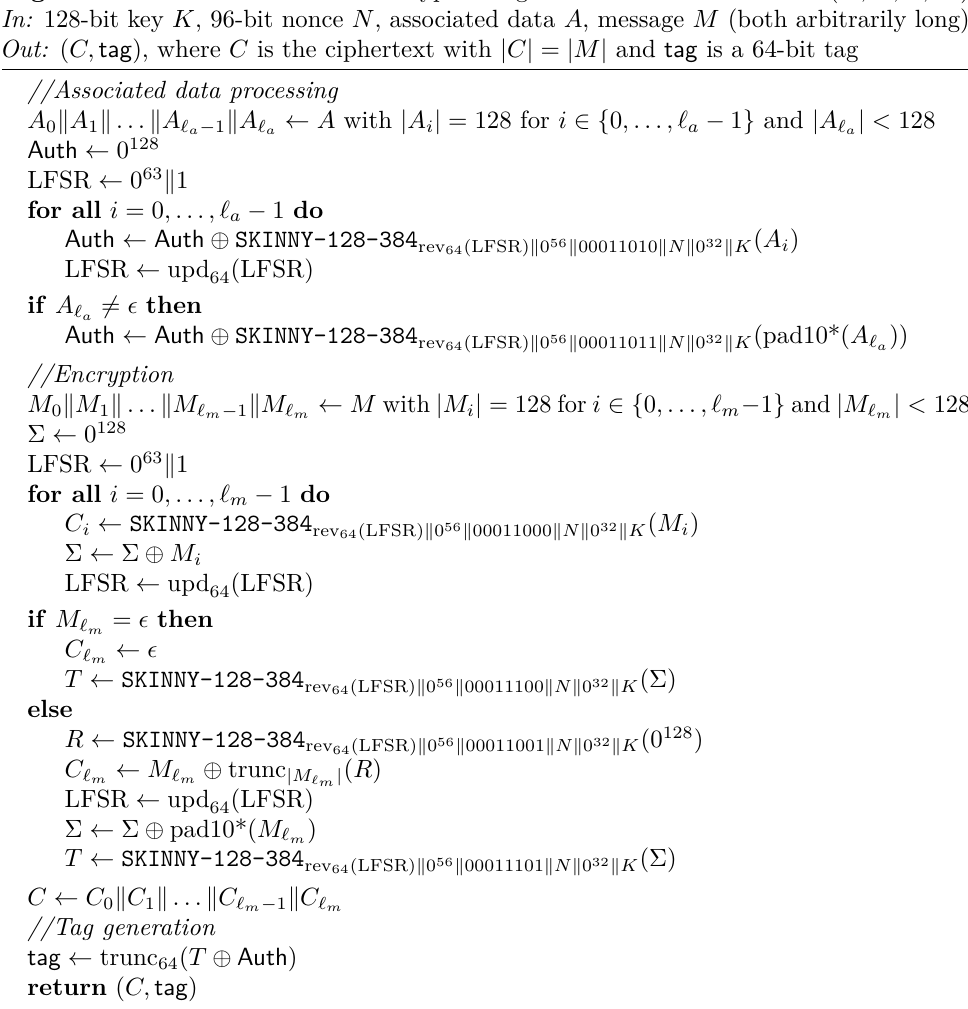
Algorithm 9 The authenticated encryption algorithm SKINNY - AEAD - M4 - Enc ( K, N, A, M